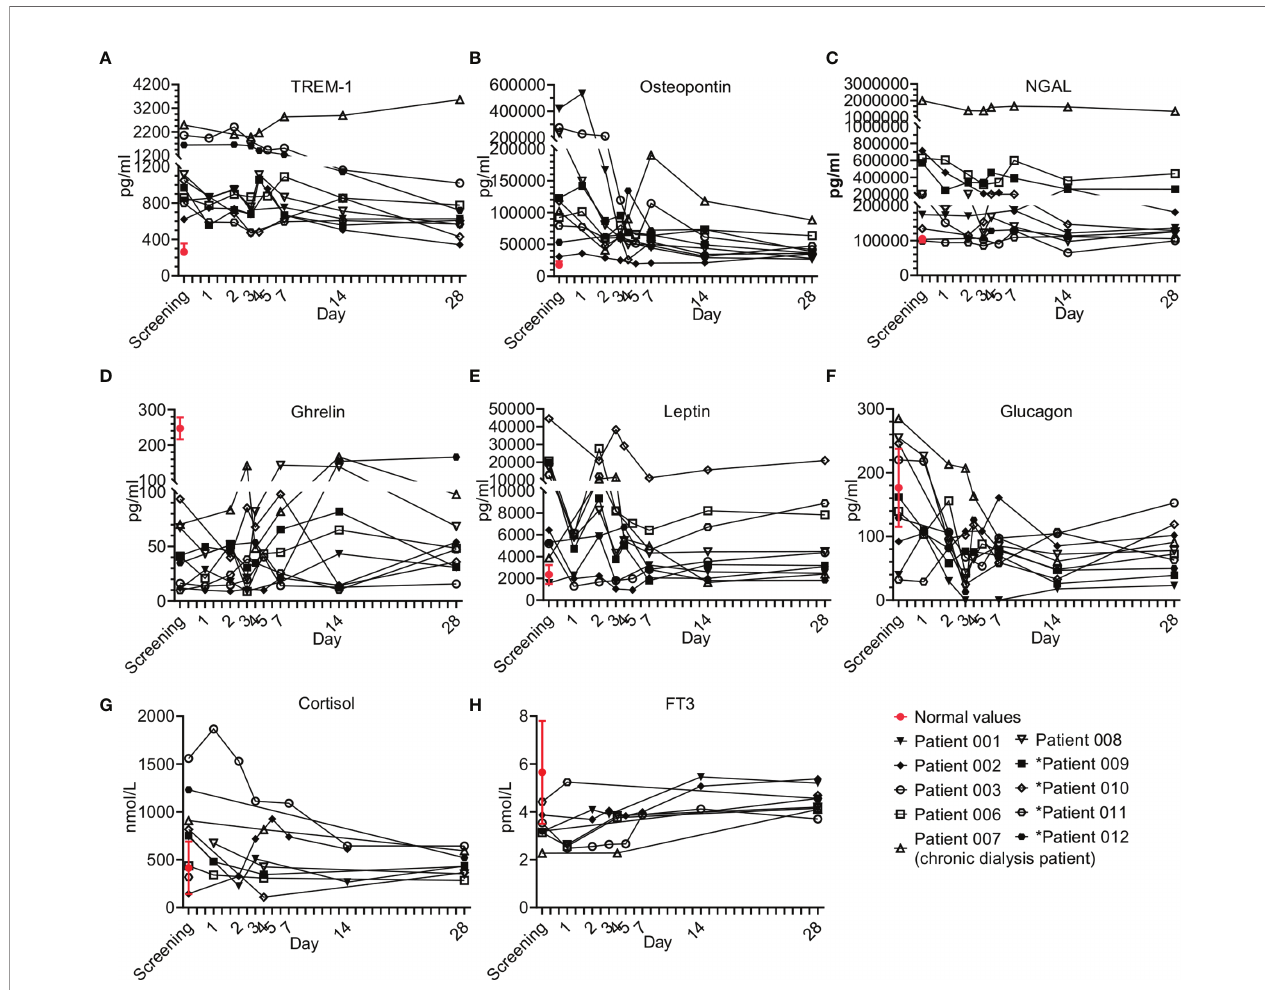
FIGURE 8 | Immune modulator and endocrine hormone kinetics during sepsis. Serum was obtained from patients at the indicated times and cytokine/growth factors analysis was performed as described in Methods. The serum of three healthy volunteers was analyzed using the same methods and values presented as the normal range (median ± range). Serum concentrations of (A) TREM-1, (B) osteopontin, (C) N-GAL, (D) ghrelin, (E) leptin, and (F) glucagon, (G) cortisol, and (H) FT3 are presented in the lower panel. Patients 01 – 08 received one dose of Allocetra-OTS on day 1 and patients 09 – 12 received two doses on days 1 and